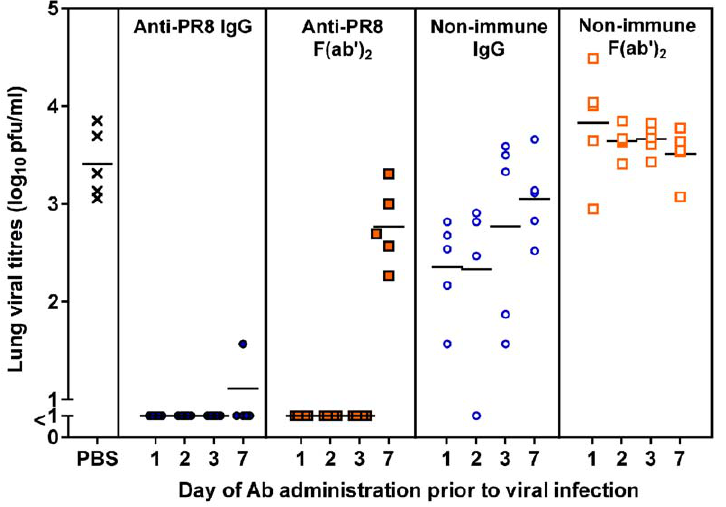
Figure 6. Anti-PR8 IgG and F(ab’)2 preparations can completely prevent influenza infection. BALB/c mice (n=5) were given 1 mg of the Ab preparations or PBS via the TRT route in 50 m l under penthrane anaesthesia. One, 2, 3 or 7 days later, mice were infected with 50 pfu of PR8 virus in 50 m l via the TRT route under penthrane anaesthesia. One day post-infection, mice were killed and lungs were collected in 1 ml media. Viral titres were determined by plaque assay on MDCK cell monolayers. Each symbol represents an individual mouse and the line represents the mean of each group. The experiment was carried out in its entirety once and results are consistent with repeat experiments on selected doses.